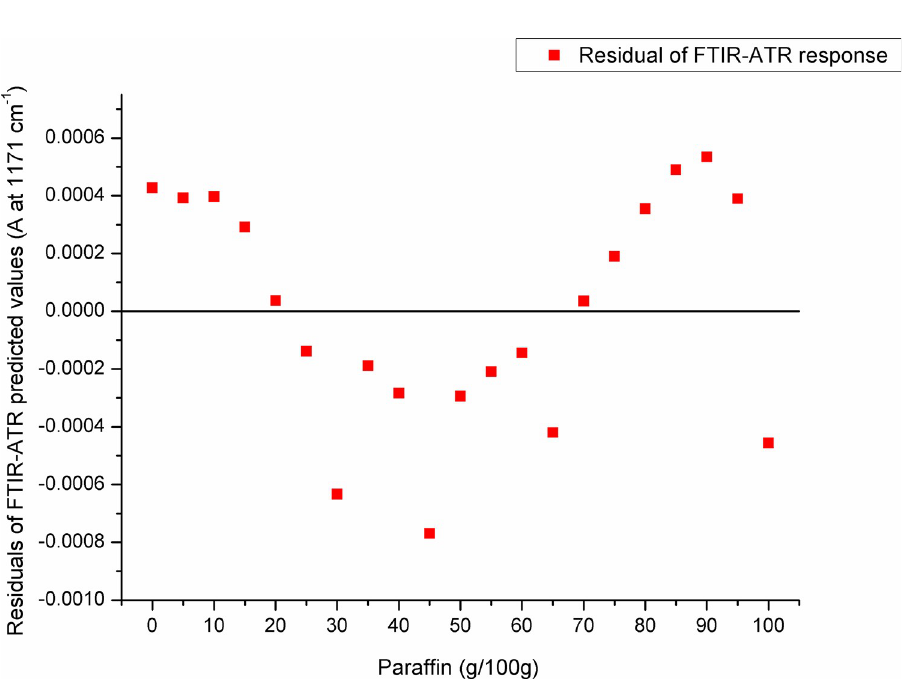
Fig 8. Residuals of FTIR-ATR prediction in the spectral region with an absorption maximum at 1171 cm -1 .